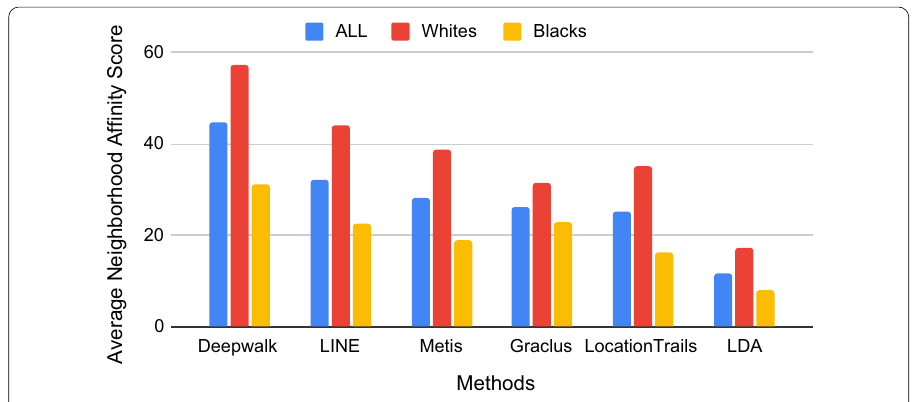
Fig. 9 Average neighborhood affinity score in white and black dominated neighborhoods. Number of communities 18 =